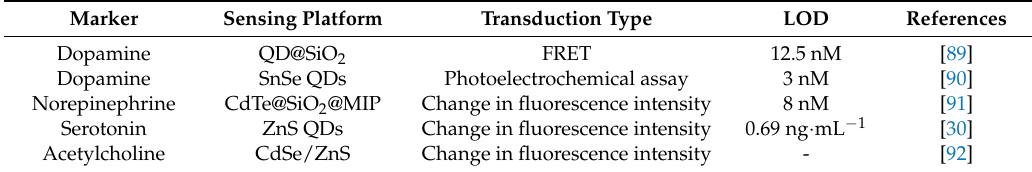
Table 6. QDs-based sensors for neurotransmitters